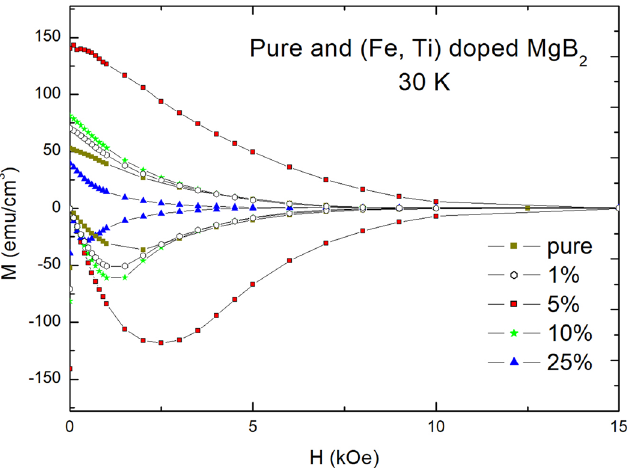
Figure 3. Field dependences of magnetizations (M-H curves) of wt.% (Fe, Ti) particle-doped MgB 2 at 30 K, which were